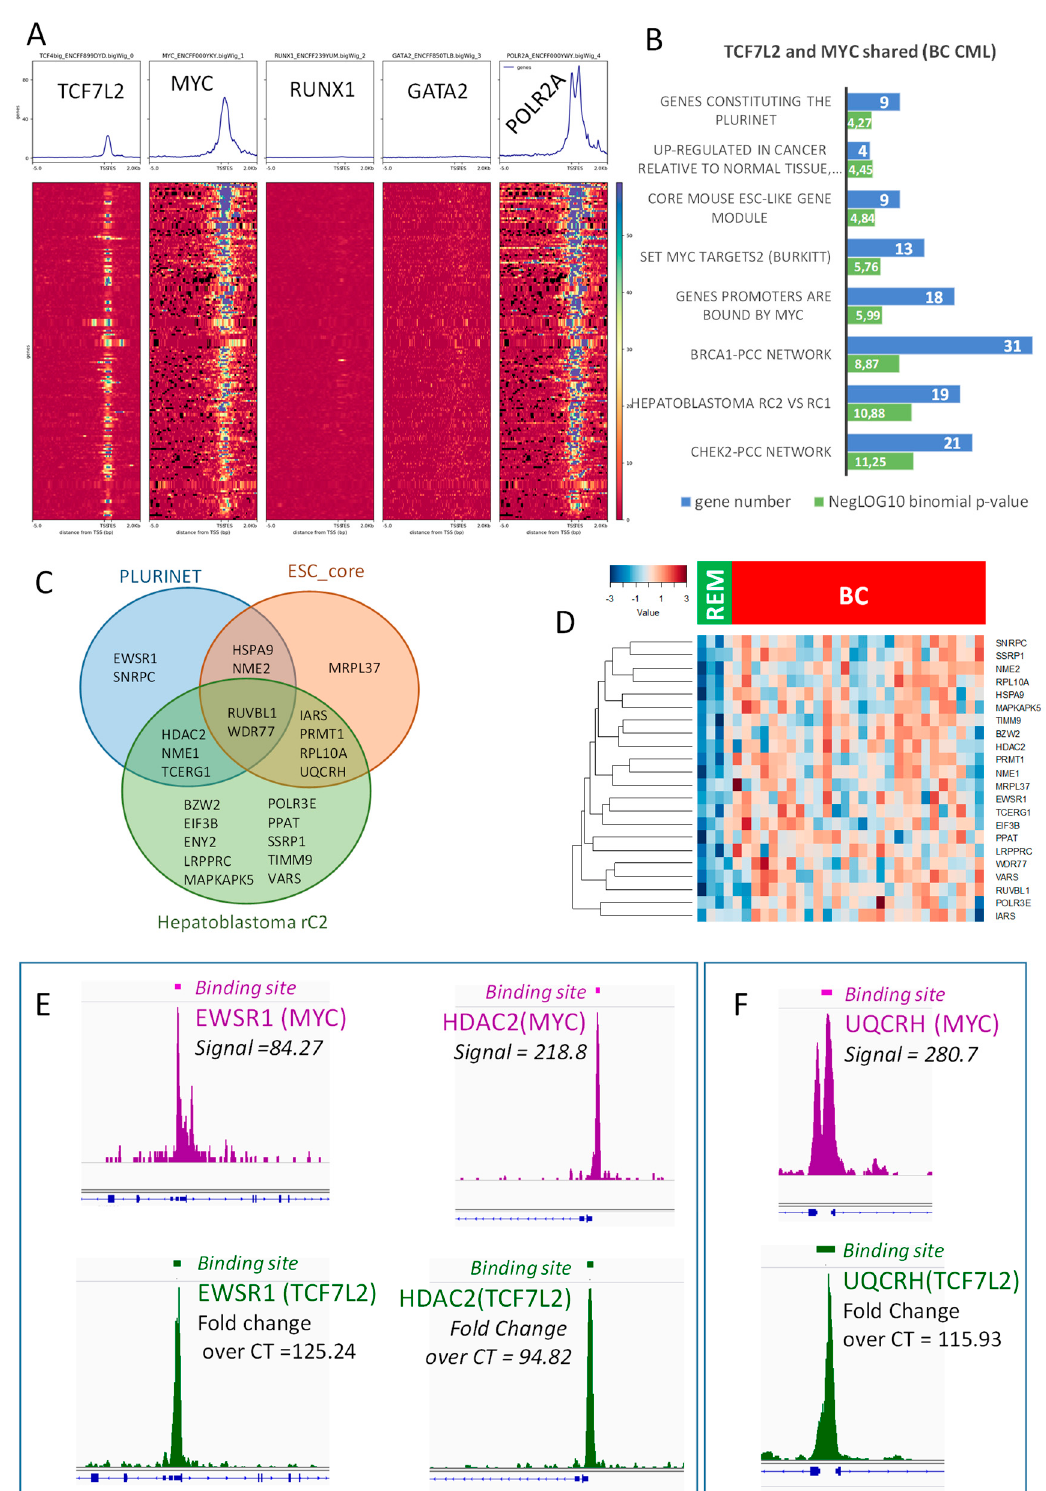
Figure 5. The TCF7L2 and MYC transcriptional program activated during blast crisis is independent of RUNX1/GATA2: ( A ) Promoter heatmap of shared TCF7L2-MYC genomic landscape positive in blast crisis of CML patients: the promoter matrix was performed compared to GATA2 and RUNX1 hematopoietic transcription factors CHIP-sequencing (ENCODE data K562) and POLR2A (positive for transcription), proximal signals were mapped from 5000 pb upstream and 2000 pb downstream from the Transcription Starting Sites (TSS); ( B ) Functional enrichment on MSigDb of the shared